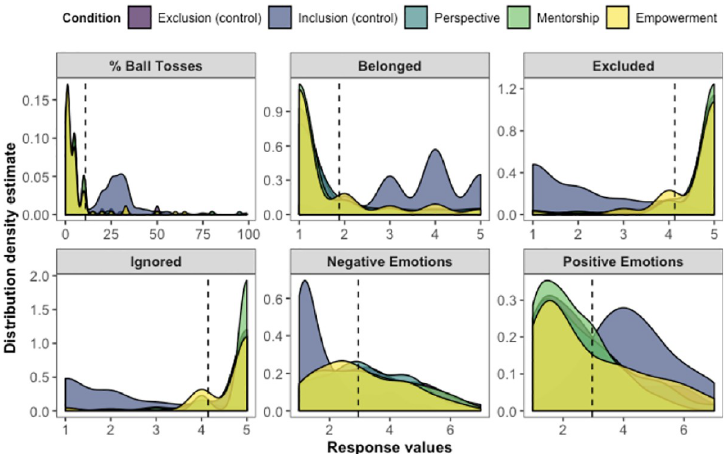
Fig 8. Distributions of manipulation check measures by condition in Study 5. Dotted lines show the overall mean response value for each measure. All main effects by condition were significant at p < .001. For estimating the percentage of ball tosses, participants typed a number between 0 and 100. For the questions on feelings of belonging, being excluded, and being ignored, participants answered using 5-point scales (1 = Not at all ; 5 = Extremely ). For questions on positive and negative emotions, we created composite indices using the individual valenced items from the Affect-Adjective Scale (1 = Not at all ; 7 = Very much so ).